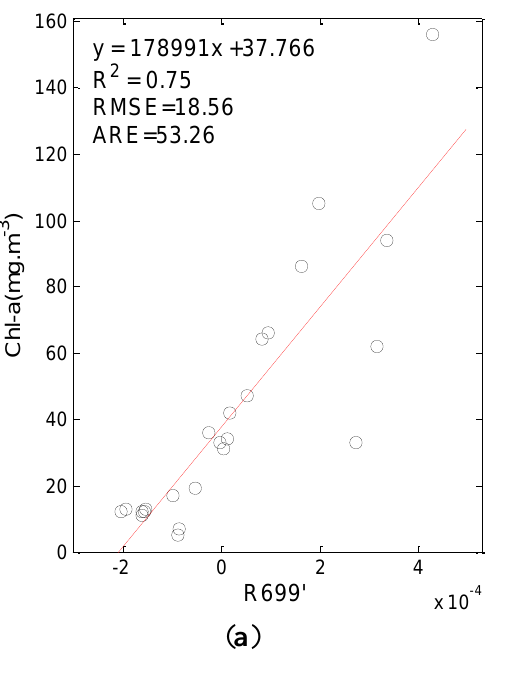
Figure 4. The Chl-a estimation model built using ( a ) the first-order derivative at 699 nm and ( b ) the second-order derivative at 685